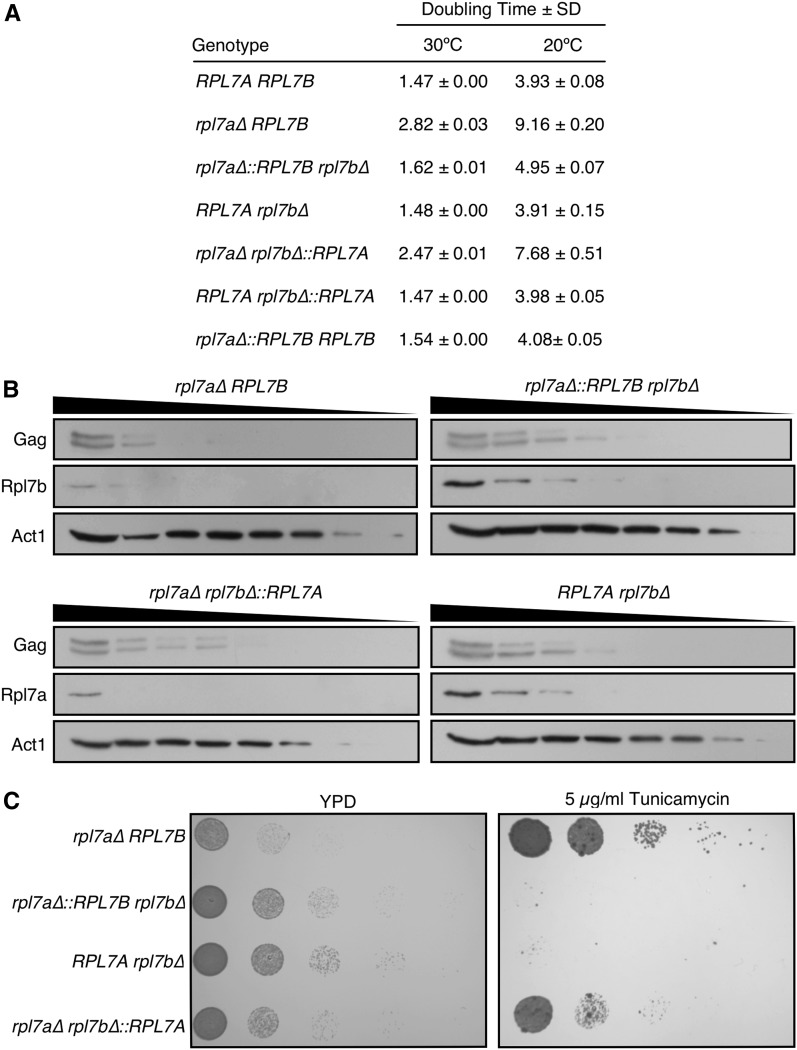
The RPL7 locus is the primary determinant of cell growth rate, Rpl7 level and tunicamycin resistance. (A) The rate of cell doubling ± SD in three biological replicates of each strain of the indicated genotype grown in YPD broth at 20 or 30° to an OD600 of 0.6. (B) Western blot analysis of Rpl7 and Ty1 Gag, which runs as a doublet, in rpl7 deletion and chimeragenic strains. Each lane from left to right represents a twofold serial dilution of whole cell lysate. Gag was detected with anti-VLP antisera, and Rpl7 isoforms were detected with polyclonal anti-human L7 antibodies. Act1 was detected with a monoclonal anti-Actin antibody as a loading control. (C) The relative tunicamycin resistance of each strain of the indicated genotype grown to an OD600 of 0.6 in YPD broth at 30°. A 5 µl aliquot of each culture, and 1:10 serial dilutions were plated on YPD agar, with or without 5 µg/ml tunicamycin. Plates were incubated at 30° for 1 d (YPD) or 5 d (YPD with tunicamycin).